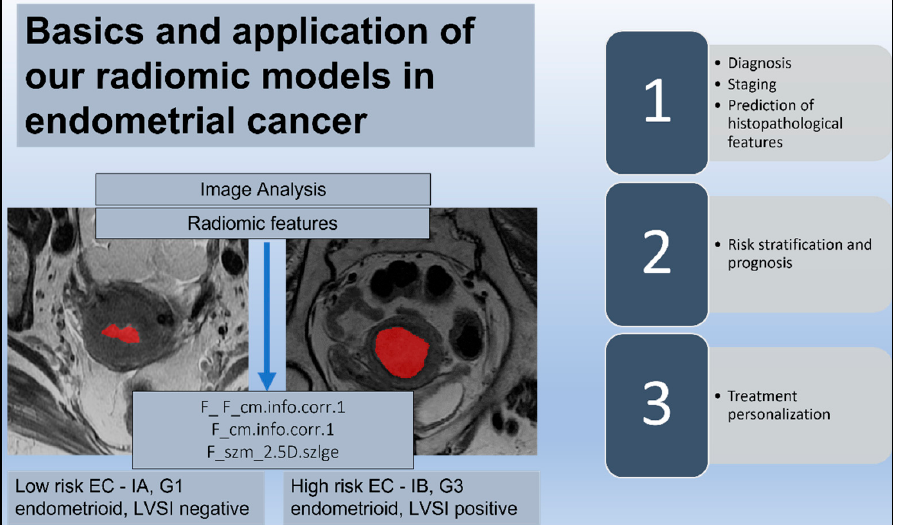
Figure 4. Radiomic signature. The endometrial tumor is delineated by a red area on T2-weighted images in two different patients with a histological diagnosis of endometrial cancer (EC); low risk ECs are defined as stage IA endometrioid, grade (G) 1–2, and lymph vascular space invasion (LVSI) negative; high-intermediate risk ECs are identified as stage IB endometrioid, G 3, regardless of LVSI status. The reported radiomic features (F) are the most significant for the prediction of histopathological factors such as deep myometrial invasion and LVSI and for the discrimination of low-risk ECs. The diagram also shows possible correlations and applications of radiomic signatures and clinical factors in EC.